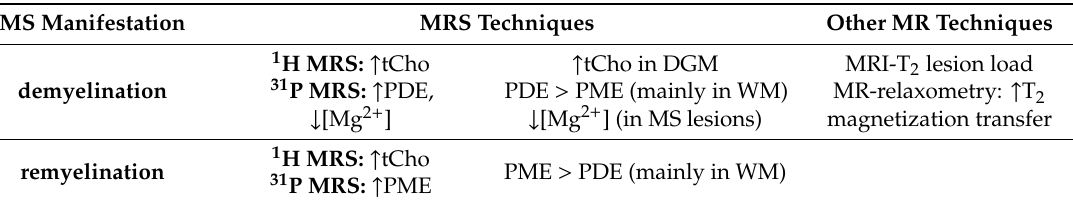
Table 2. Summary of MR techniques in MS assessment. Table summarizing MRS and other MR techniques suitable for MS assessment and typical disease